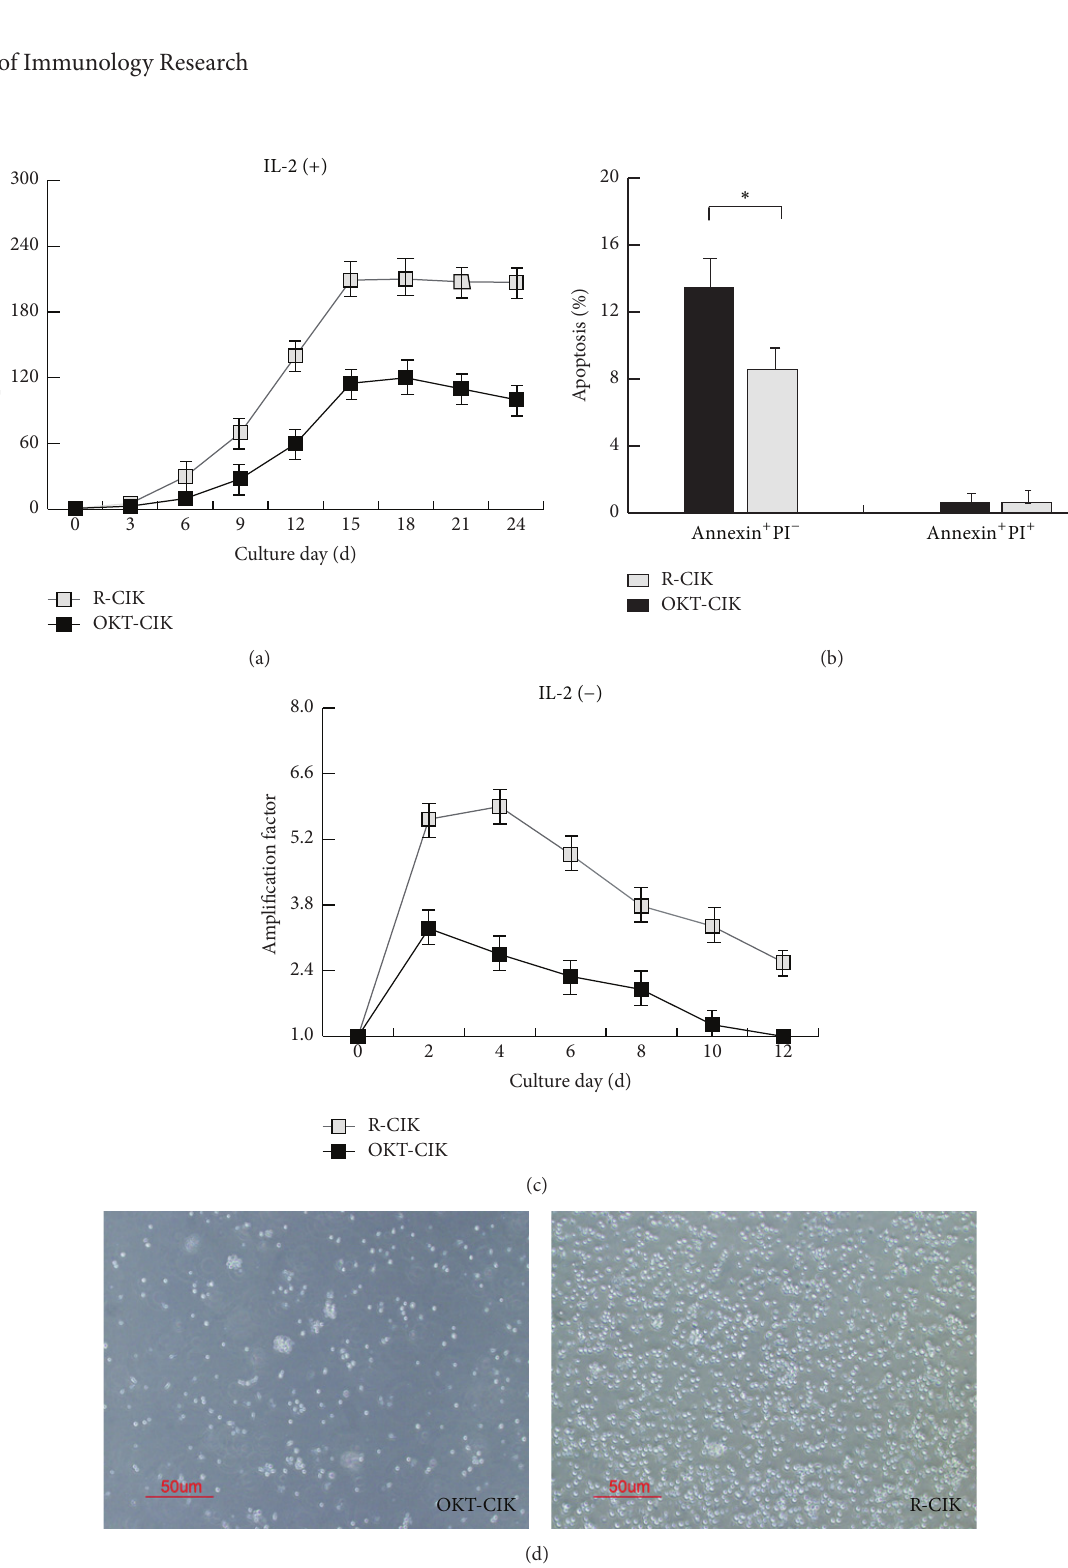
Figure 1: RetroNectin activated CIK cells had stronger proliferative ability. (a) Proliferative curve of OKT-CIK and R-CIK cells. The proliferative speed of R-CIK cells was much higher than that of OKT-CIK cells, 𝑛 = 5 . (b) Mean percentage of OKT-CIK and R-CIK cells undergoing early apoptosis (Annexin + PI − ) and late apoptosis/necrosis (Annexin + PI + ). ∗ 𝑃 < 0.05 for the comparison, 𝑛 = 5 . (c) Continual proliferative curve of OKT-CIK and R-CIK cells in medium without IL-2. R-CIK cells could continue expanding 4 days after IL-2 was withdrawn from the medium, and the maximum average amplification is 6 times. OKT-CIK cells could only continue expanding 2 days in the same condition, and the maximum average amplification is 3 times, 𝑛 = 5 . (d) Shape of cultured OKT-CIK and R-CIK cells